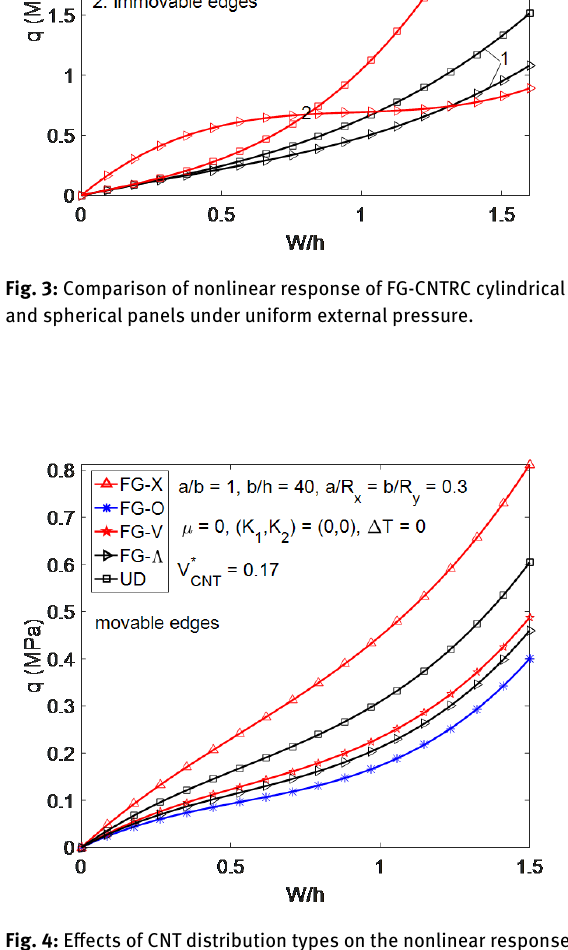
Fig. 4: Effects of CNT distribution types on the nonlinear response of CNTRC spherical panels under uniform external pressure with movable